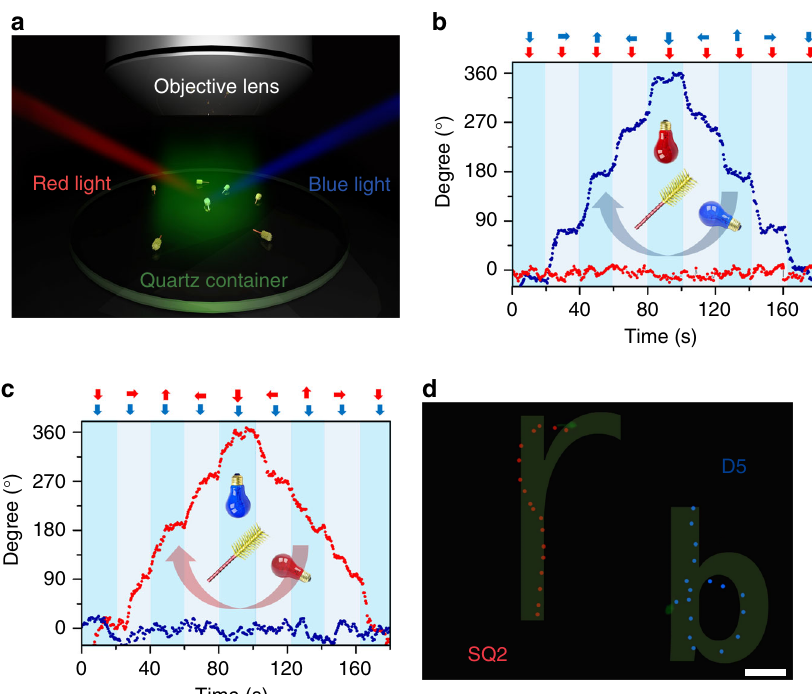
Fig. 4 The orthogonal orientation control and navigation of the dye-sensitized microswimmers. a The schematics of the experimental setup where the blue (475 nm) and the red (660 nm) side illumination are used to control the orientation of the microswimmers while the green (550 nm) top illumination is used for imaging. b The angle of the D5 (blue) and SQ2 (red) sensitized microswimmers under fi xed 660 nm illumination with rotating 475 nm illumination c The angle of the D5 (blue) and SQ2 ( red ) sensitized microswimmers under fi xed 475 nm illumination with rotating 660 nm illumination. The red and blue arrows in b , c indicate the light propagation direction of the corresponding light. d . The trajectory of SQ2 (red) and D5 (blue) sensitized microswimmers spell ‘ r ’ and ‘ b ’ spontaneously as navigated with the blue and red light (scale bar: 20 μ